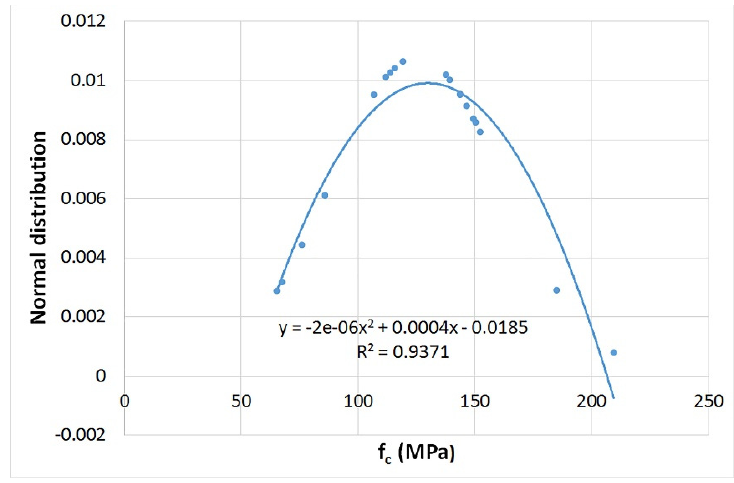
Figure 8. Gauss distribution of cylindrical compression strength of stone cores.